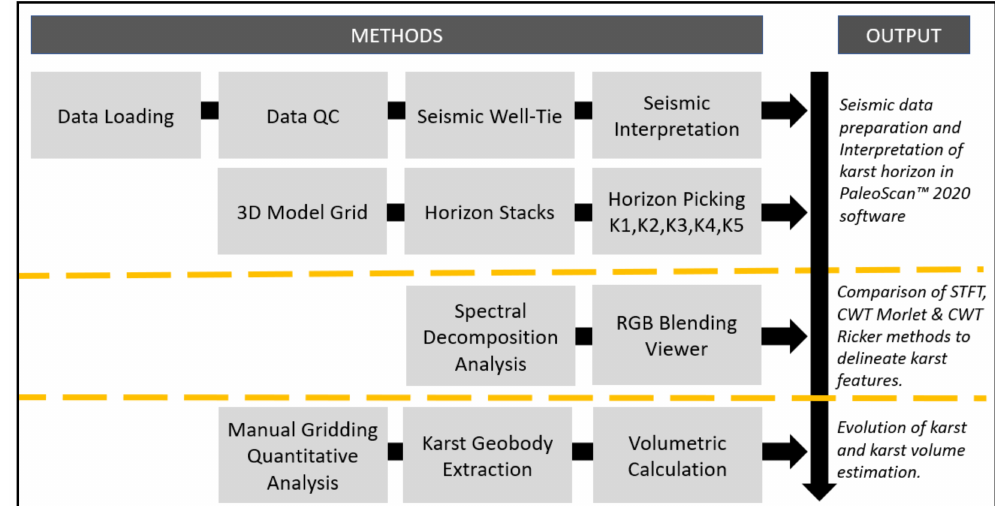
Figure 3. Methodology and workflow used for the interpretation of karst geobodies from 3D seismic using spectral decomposition techniques. Geobody extraction and volumetric calculation complemented the analysis to estimate the volume of the karst geobody in the Jintan and M1